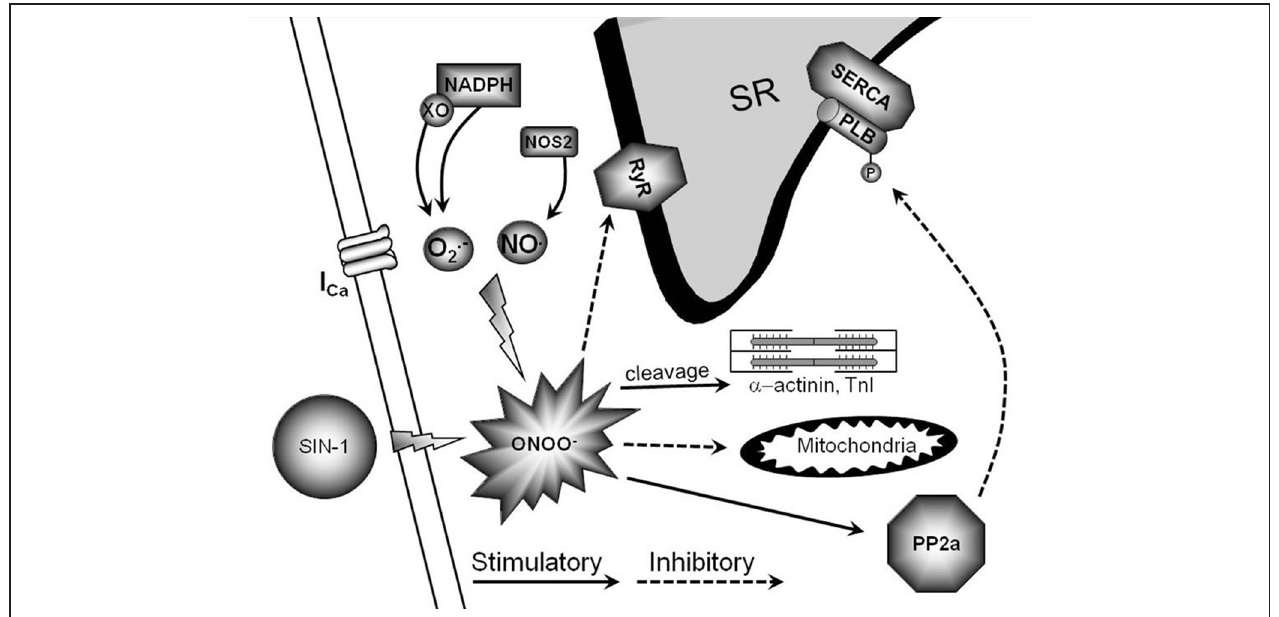
FIGURE 2 | Pathophysiological signaling pathway of high peroxynitrite. This is a diagrammatic representation of high peroxynitrite signaling and various proposed end targets within the cardiomyocyte. The endogenous production of high levels of peroxynitrite can occur via NOS2/NADPH oxidase/xanthine